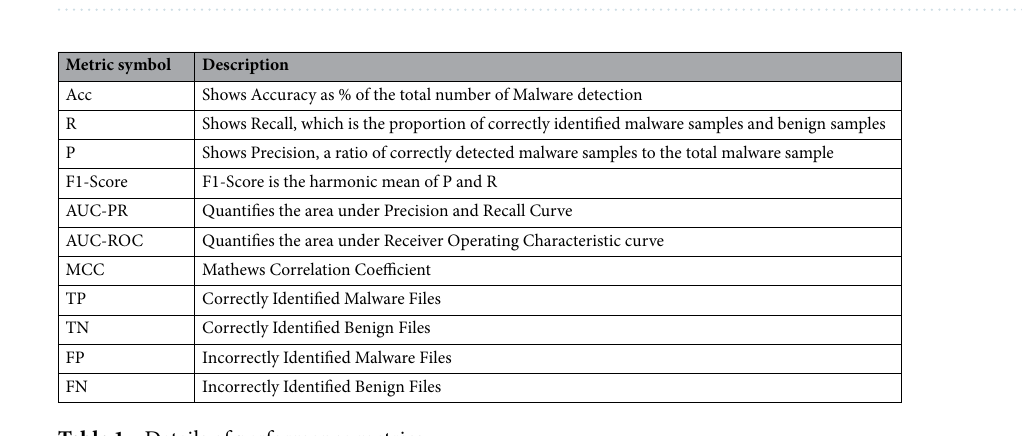
Figure 5. Image visualization of ( a ) malware and ( b ) benign files.